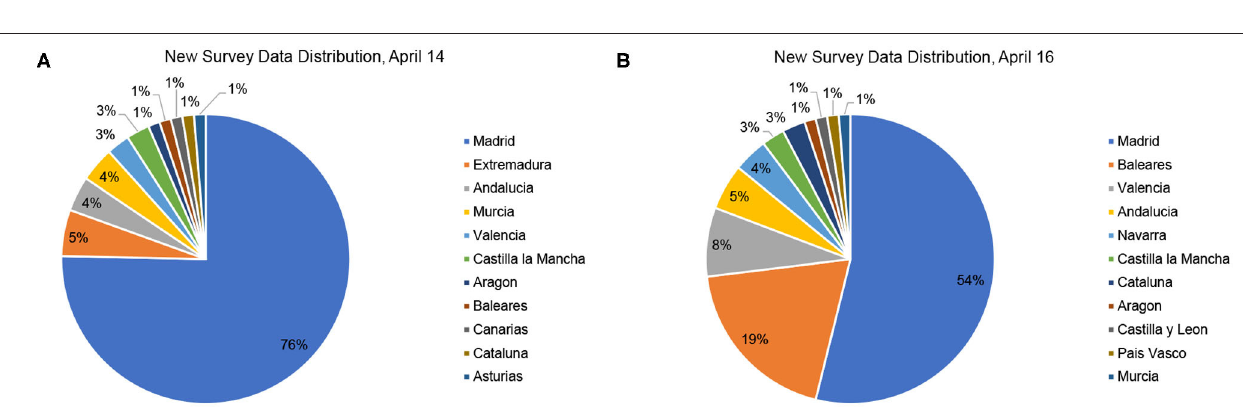
FIGURE 3 | Distribution of new survey responses on April 14 (A) and April 16 (B)